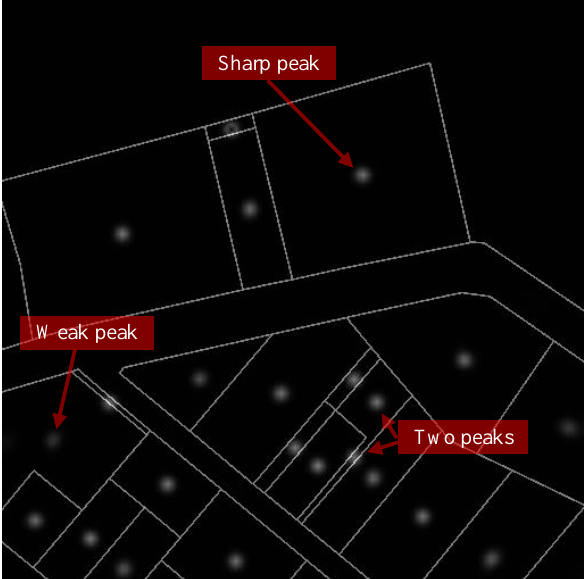
Figure 7. Example of output heatmap (128 x 128 pixels) by trained key-point detection model